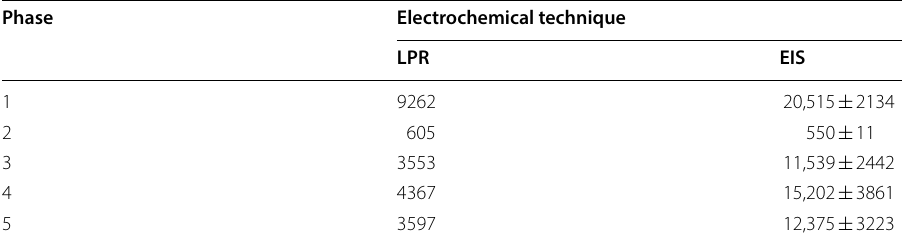
values (Ω cm 2 ) calculated from the R p · R R p = film + ct